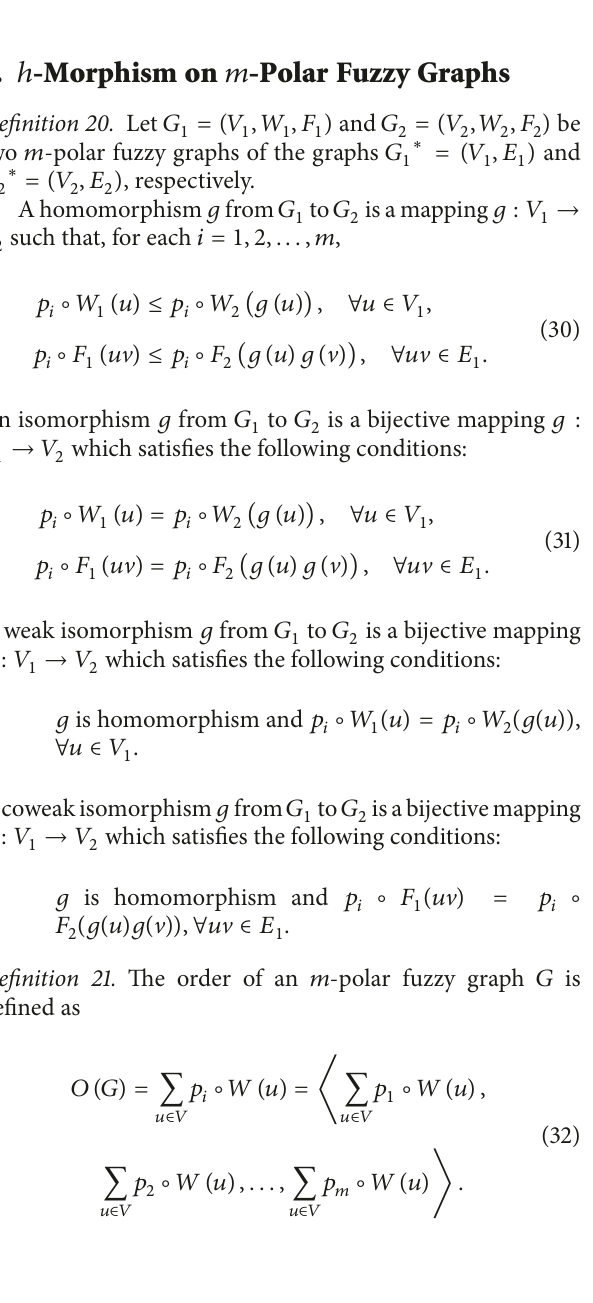
Figure 3: ℎ -morphism of 𝑚 -polar fuzzy graphs 𝐺 1 and 𝐺 2